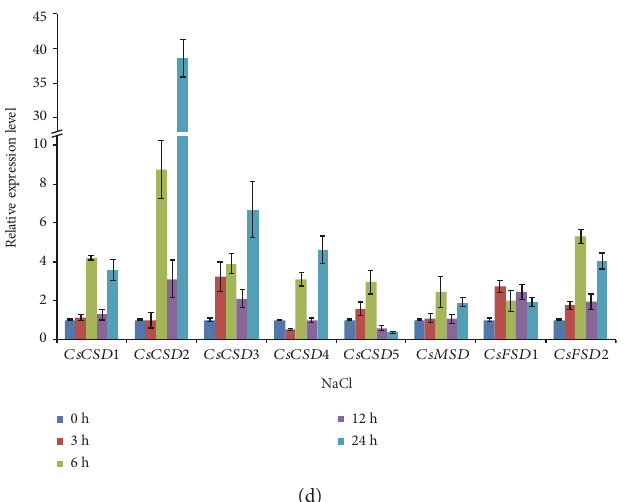
Figure 7: qRT-PCR analysis of cucumber SOD genes in response to various abiotic stresses including heat (a), cold (b), PEG (c), and NaCl (d). Error bars indicate SD based on three biological